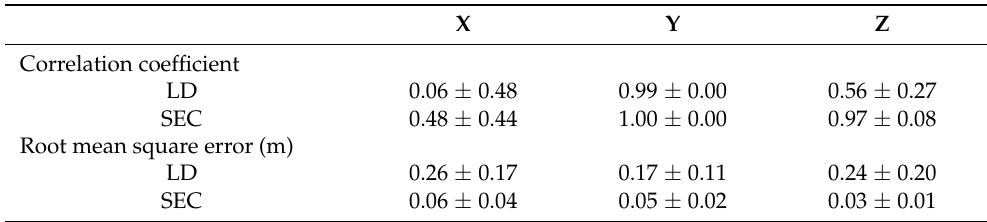
Figure 6. Example of foot trajectories obtained by linear dedrifting (LD) and spatial error correcting (SEC) methods (solid line) with reference (broken line). Table 3. Mean and standard deviation of correlation coefficient and root mean square error between foot trajectories estimated with linear dedrifting (LD) and spatial error correcting (SEC) methods and the reference trajectory.